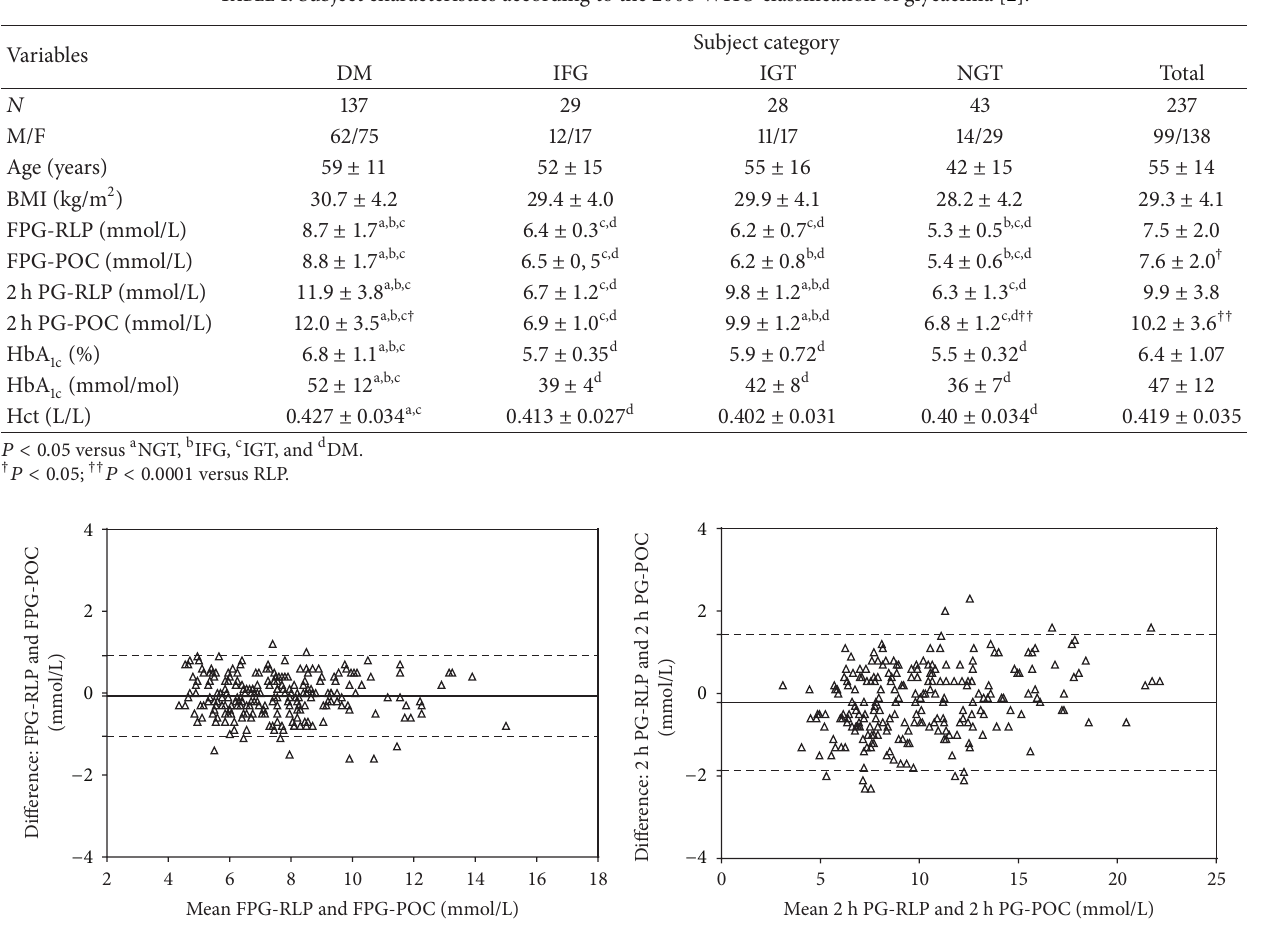
Table 1: Subject characteristics according to the 2006 WHO classification of glycaemia [2].